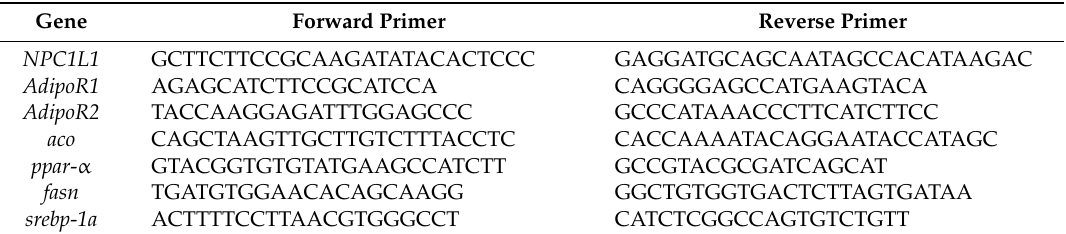
Table 2. Primer sequences for